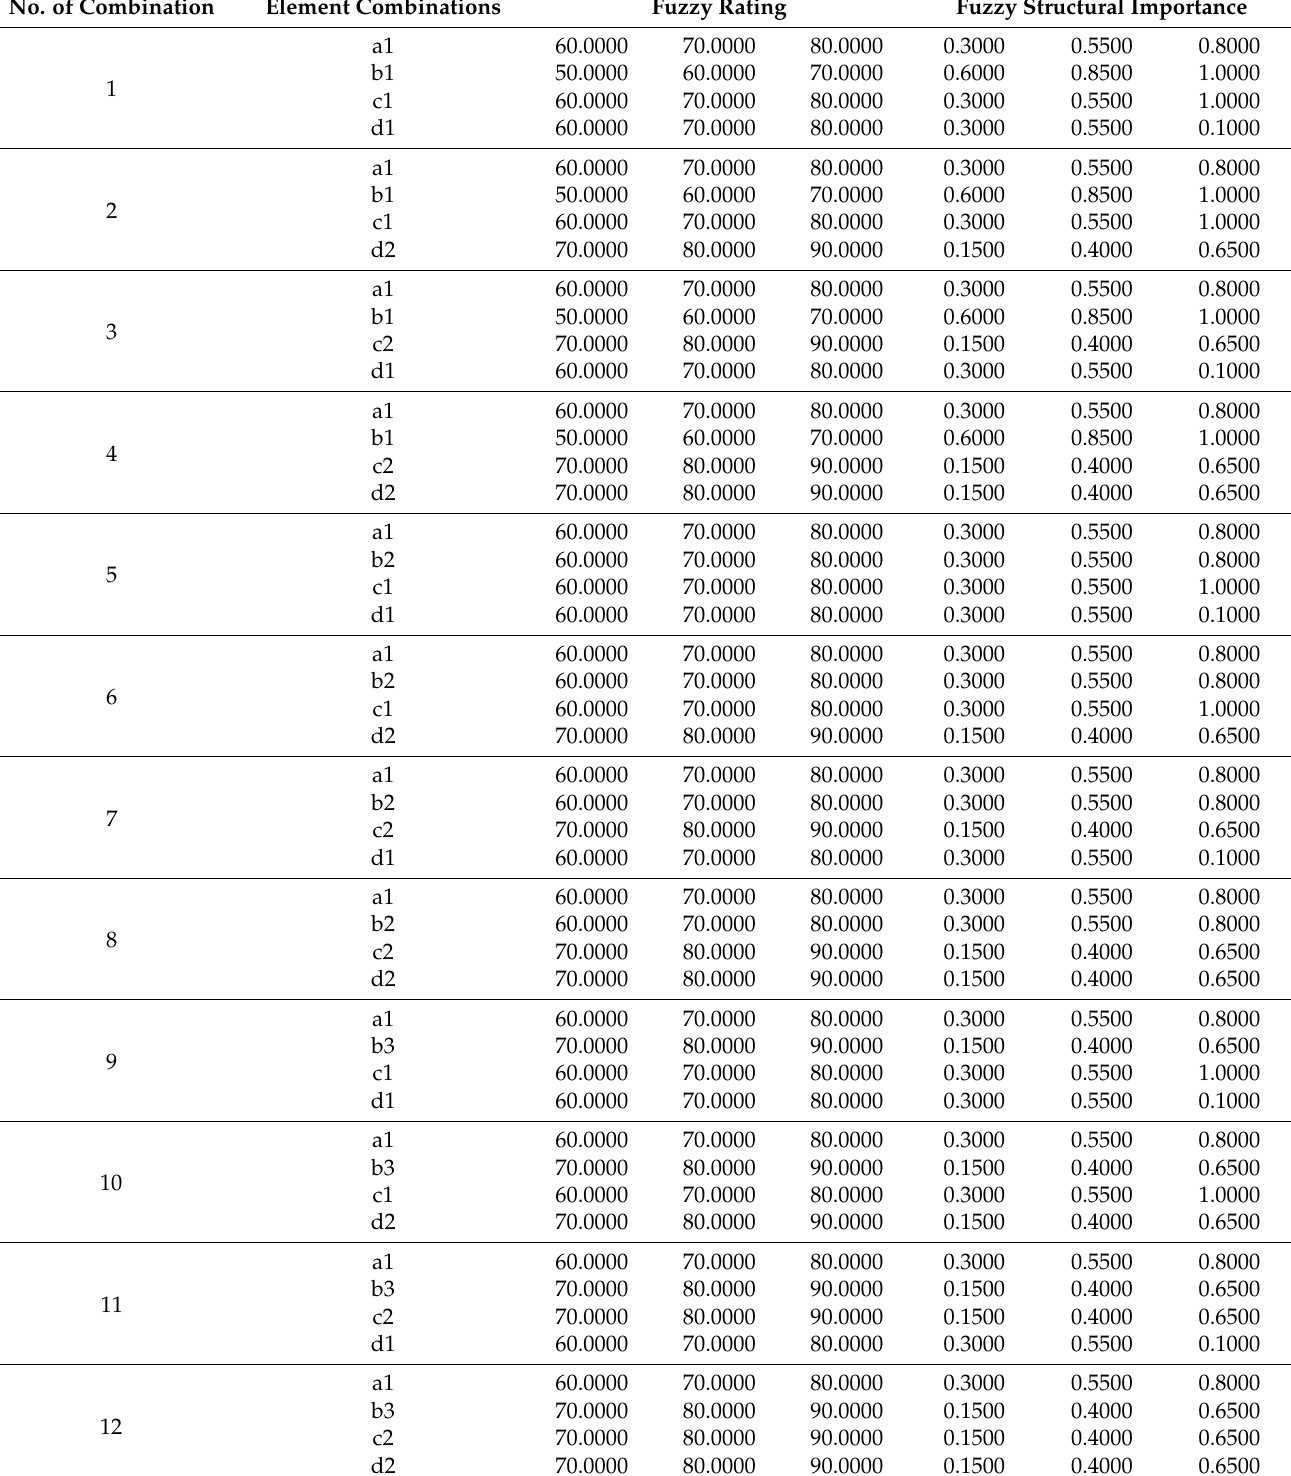
Table A1. Combinations of all elements with fuzzy ratings and fuzzy structural importance (extended version of Table